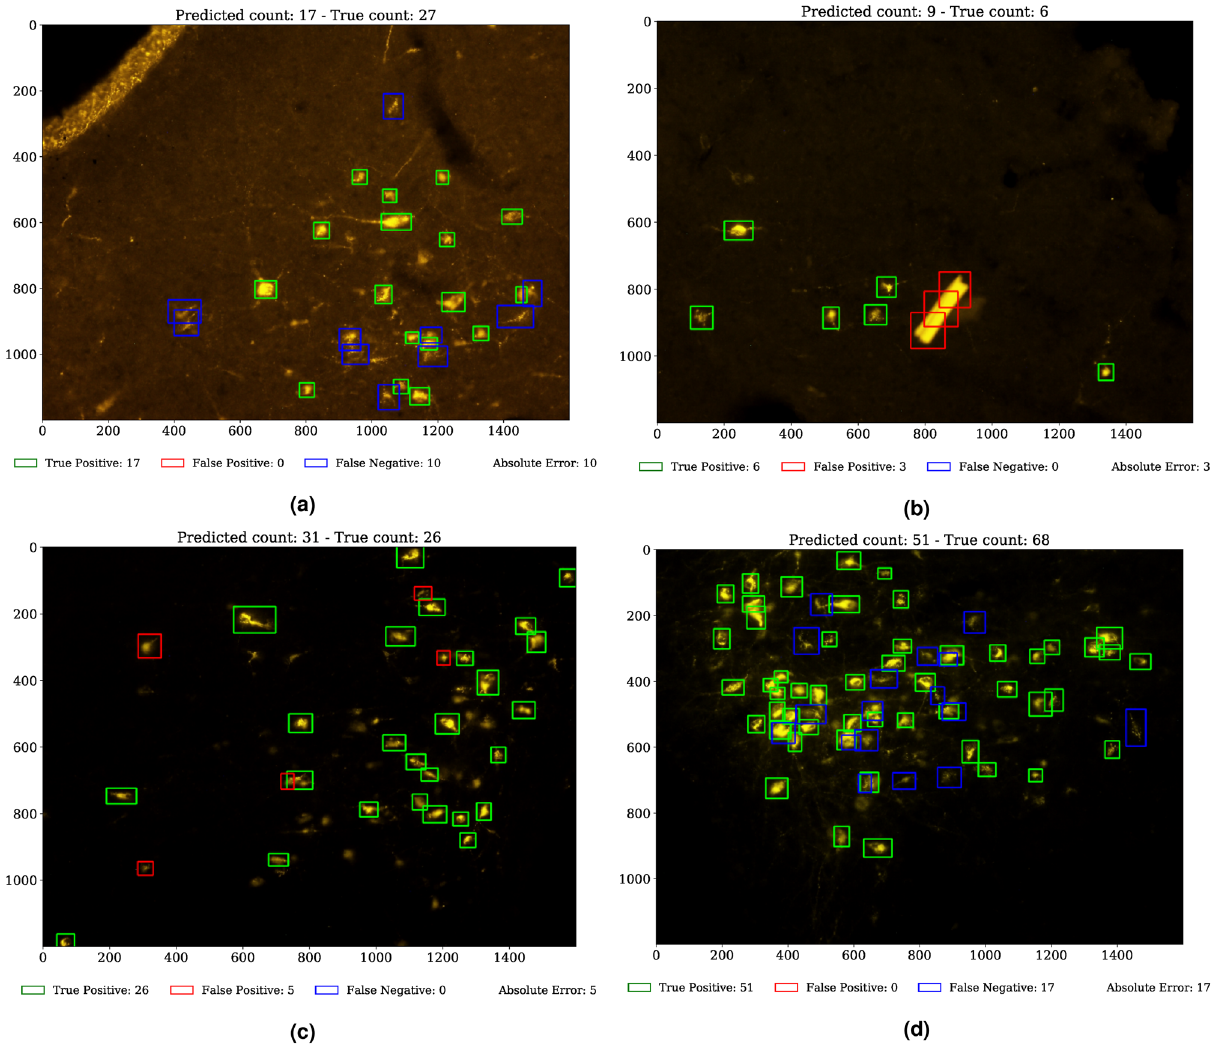
Figure 7. Results on test images. The c-ResUnet (no AO) correctly handles evident artifacts ( a , topleft corner), while the c-ResUnet fails with more problematic structures ( b ). Notice how false positives ( c , red boxes) look like target cells. Likewise, the objects discarded ( d , blue boxes) are similar to other stains that were not